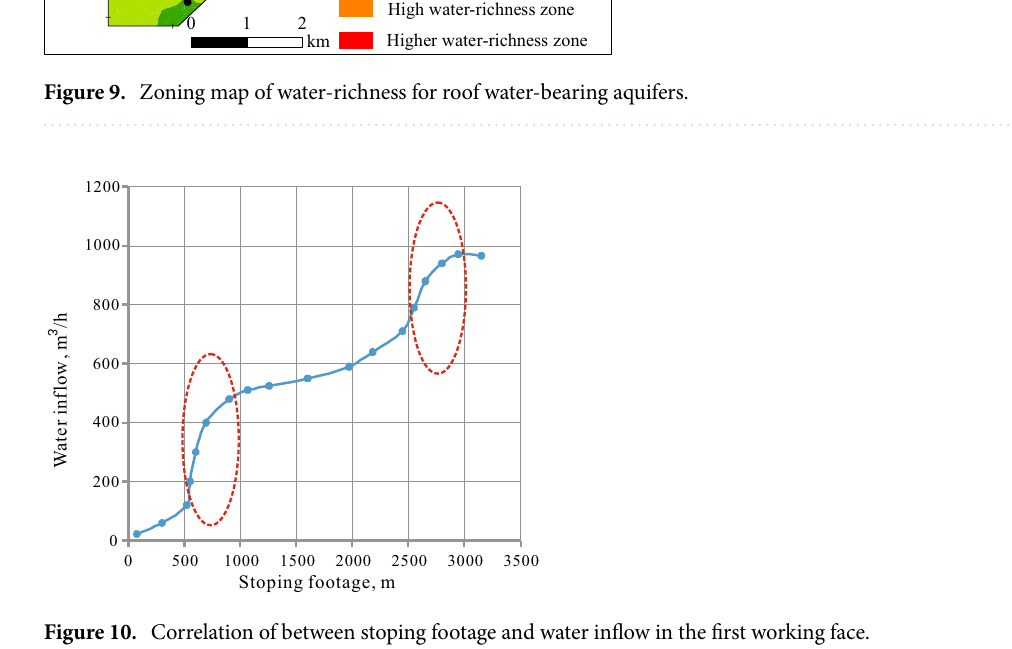
Figure 10. Correlation of between stoping footage and water inflow in the first working